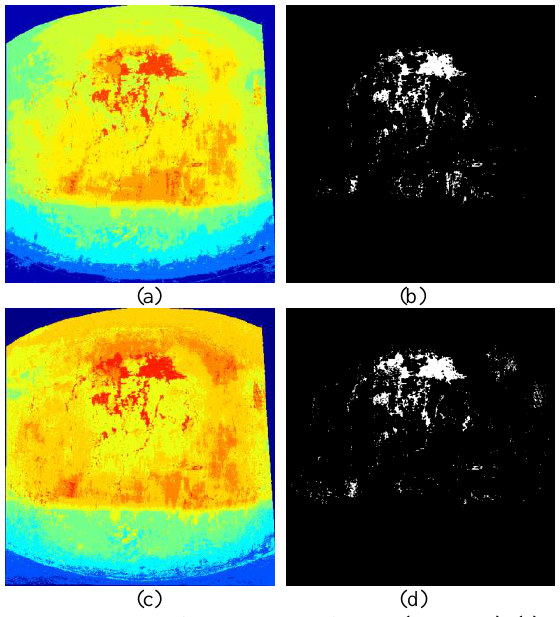
Figure 12. Classification results of wall 2 (8 clusters): (a) Original intensity; (b) damage areas detected using original intensity; (c) corrected intensity; (d) damage areas detected